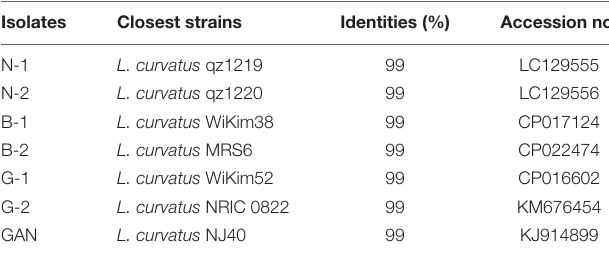
TABLE 3 | 16S rDNA sequences similarities of isolated strains with representative lactic acid bacteria.